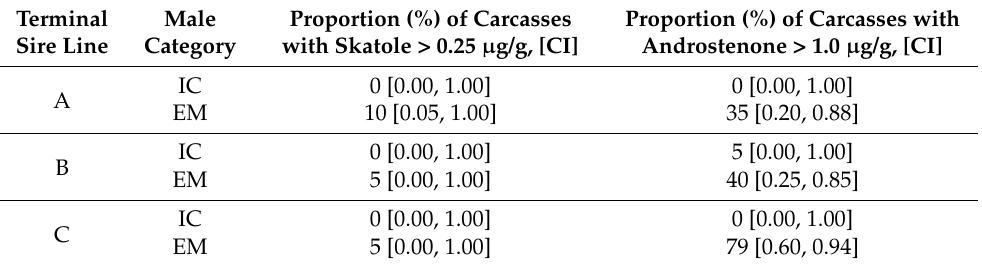
Table 4. The proportion of the “tainted” samples in different male categories according to terminal sire